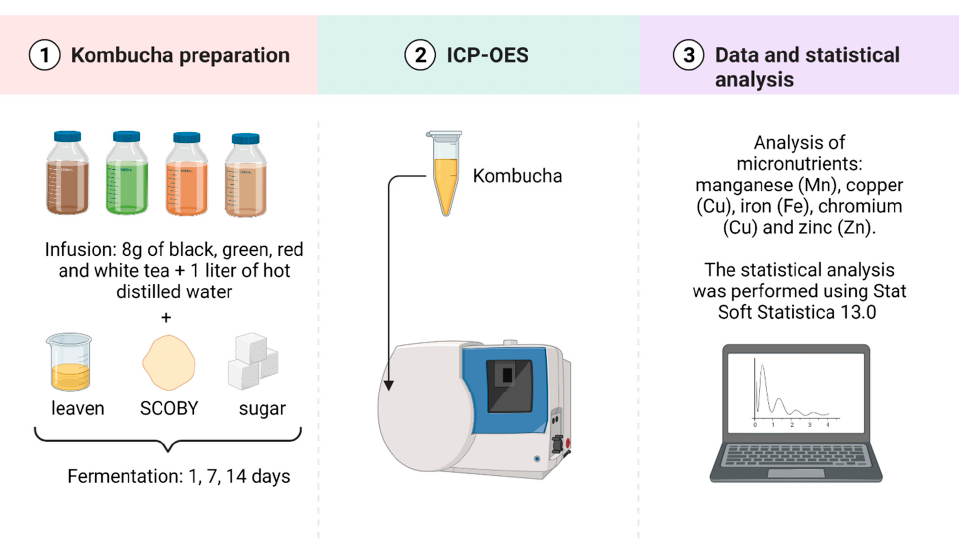
Figure 2. Material and methods—Preparation of Kombucha and laboratory analyses. Created with BioRender.com.